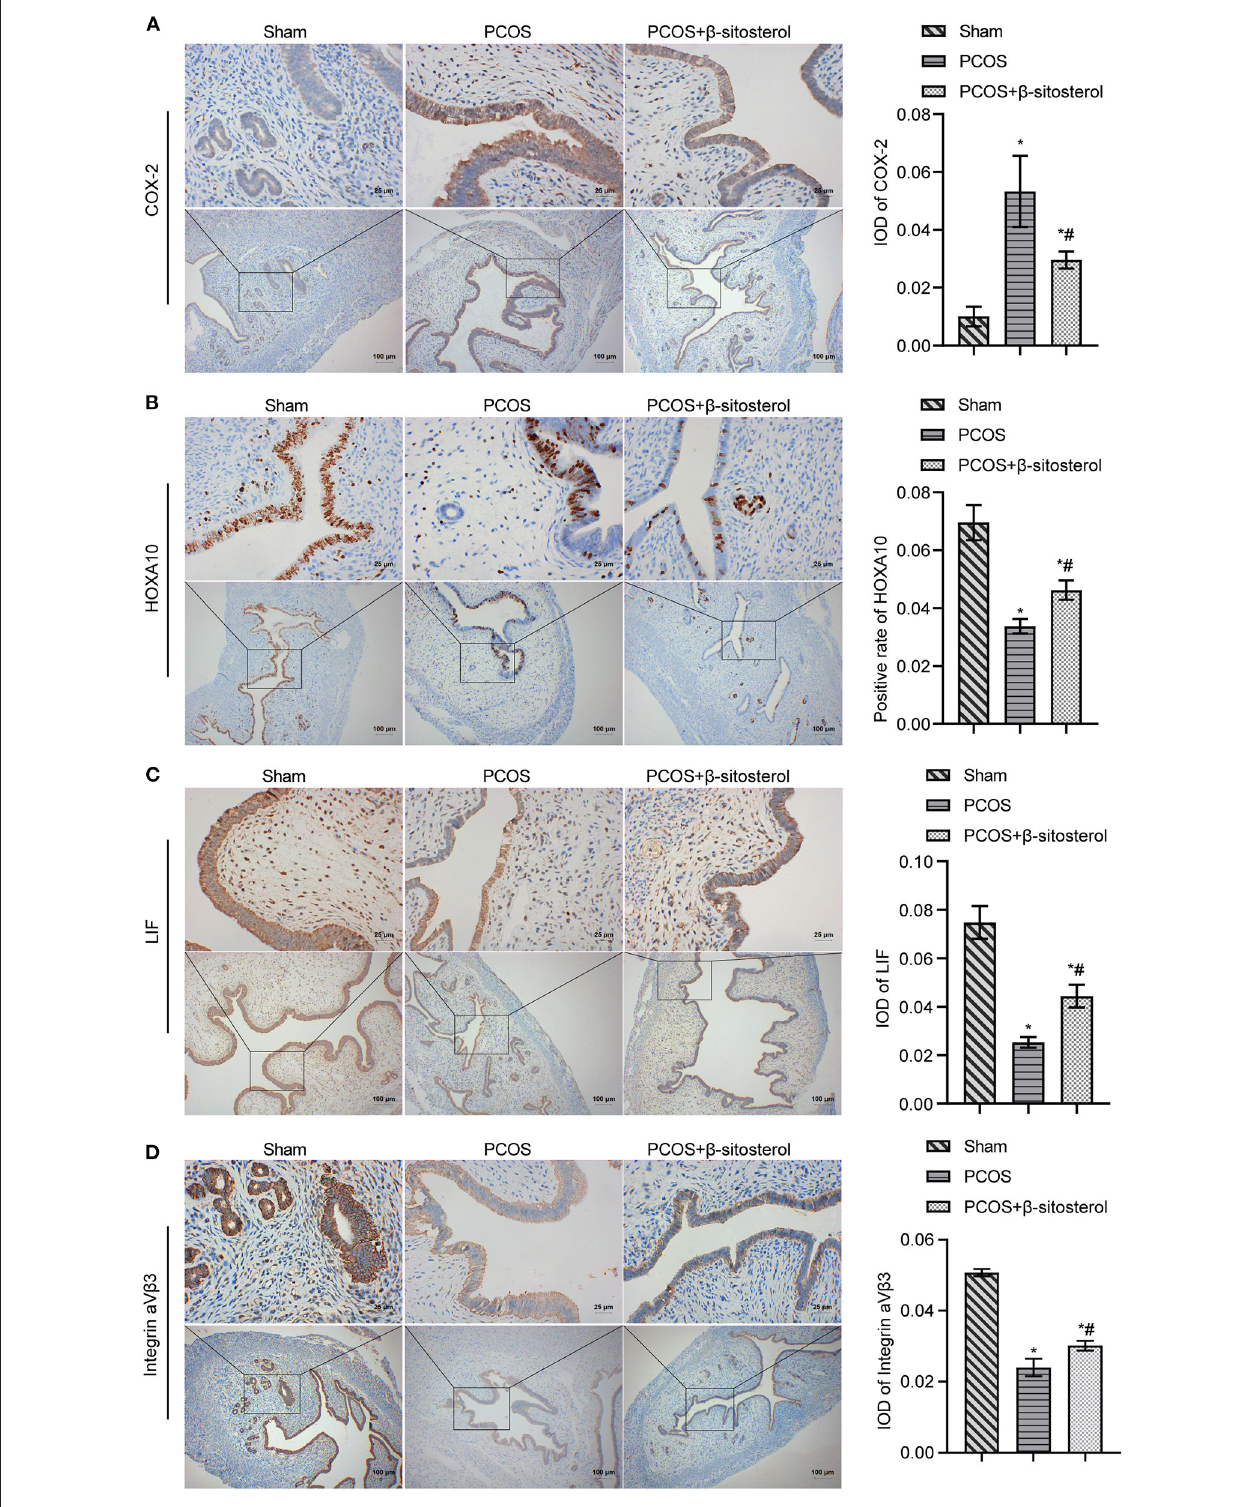
FIGURE 2 | Effect of β -sitosterol on the expression of endometrium receptivity markers and related hormones in PCOS-like mice. (A–D) Expressions of COX-2, HOXA10, LIF, and Integrin ανβ 3 in the endometrium of mice in each group detected by IHC. Upper images are magnified 400-fold (scale bar = 25 µ m) and lower images are magnified 100-fold (scale bar = 100 µ m). Data are presented as mean ± SEM. * P < 0.05 vs. Sham. # P < 0.05 vs. PCOS. PCOS, polycystic ovary syndrome; COX-2, cyclooxygenase-2; HOXA10, homeobox A10; LIF, leukemia inhibitory factor; ELISA, enzyme-linked immunosorbent assay.